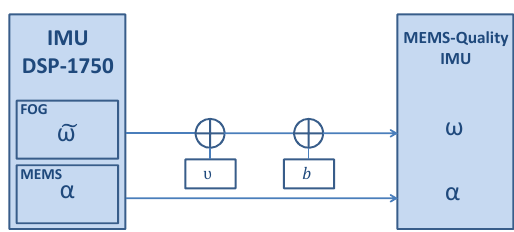
Figure 7. Diagram of the IMU DSP-1750 with the post-processing to generate MEMS-quality turn rate measurements.